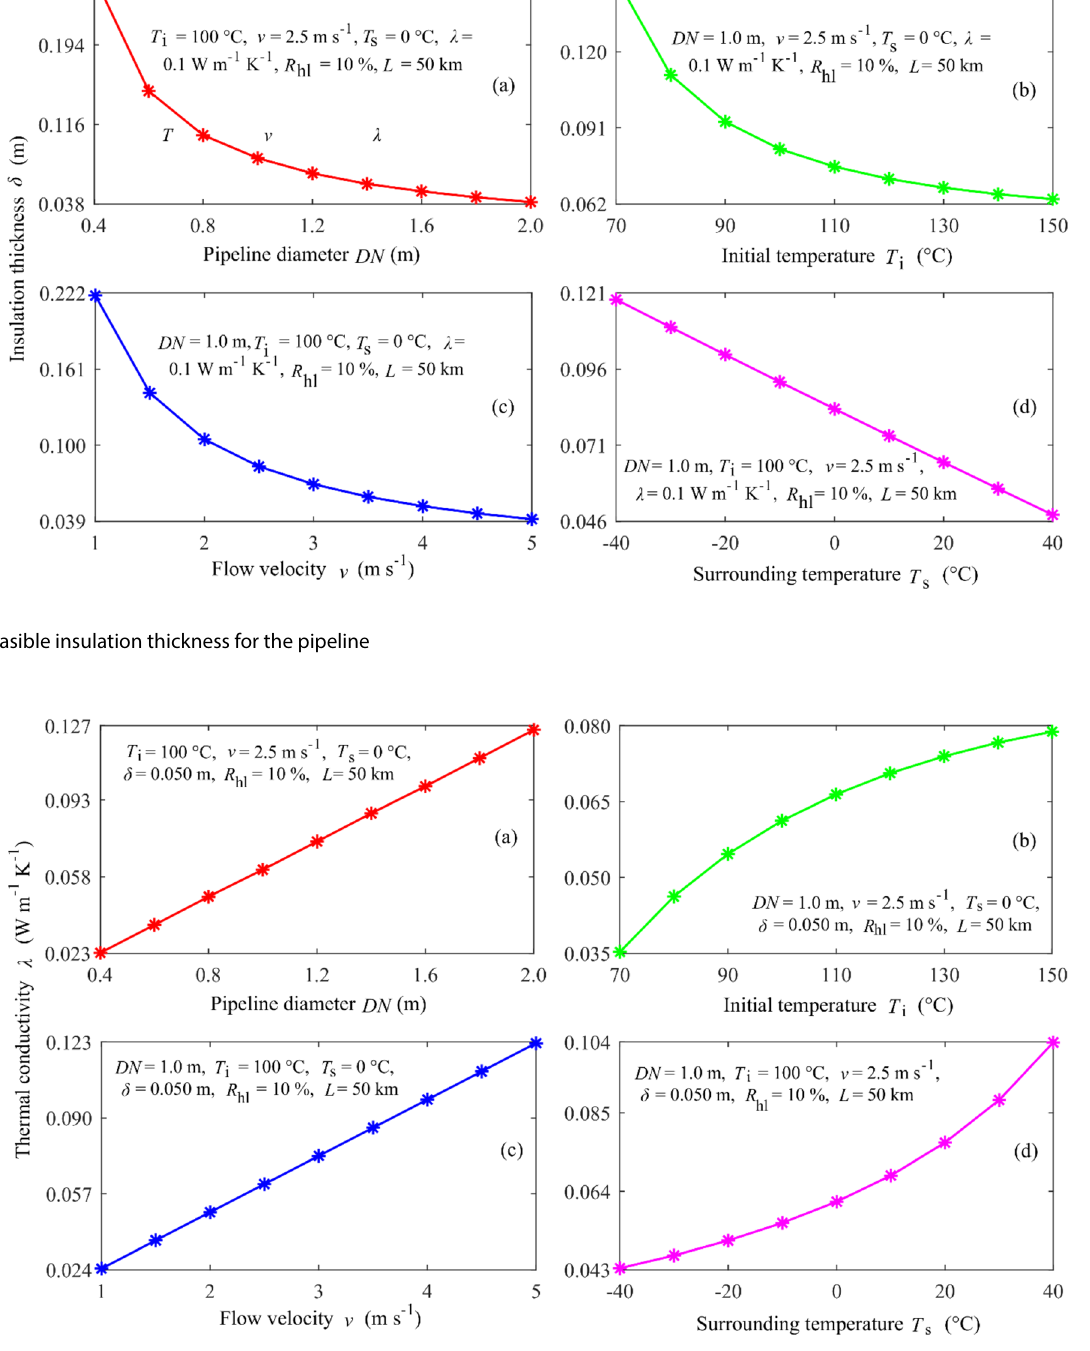
Fig. 6 Feasible thermal conductivity of the